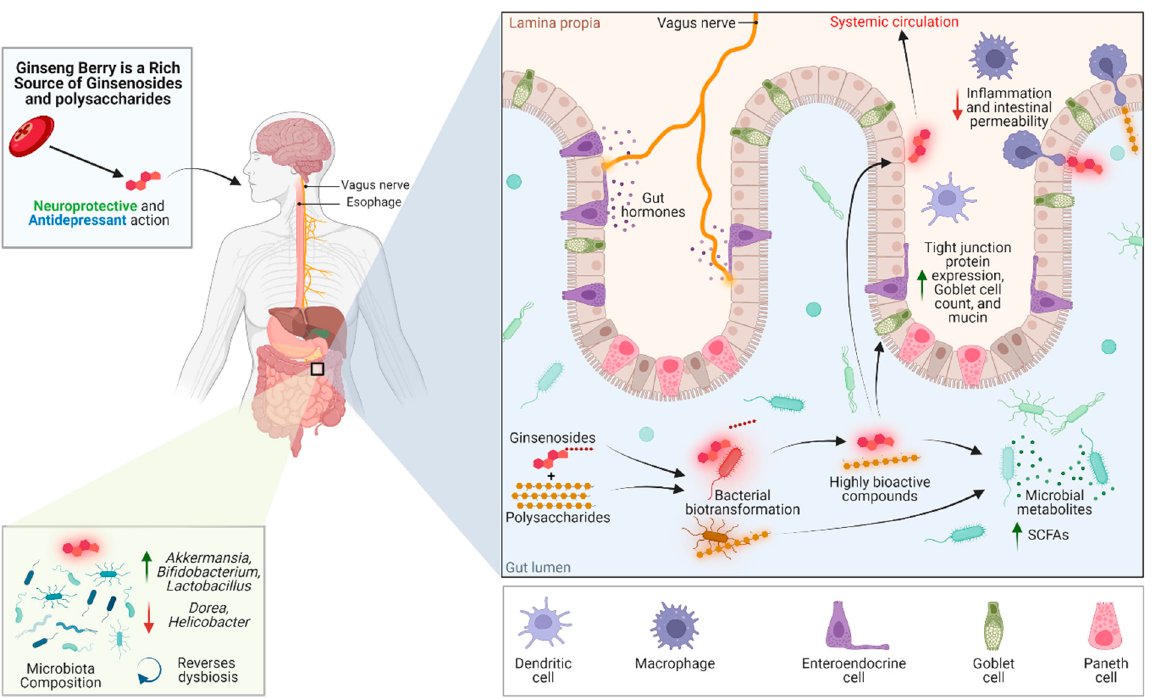
Figure 1. An overview of the reported studies highlighting the interplay of ginseng berry compounds with the microbiome–gut–brain axis. Green upward arrows represent a significant increase, whereas red downward arrows represent a significant decrease. Green arrow: increase; red arrow: decrease.